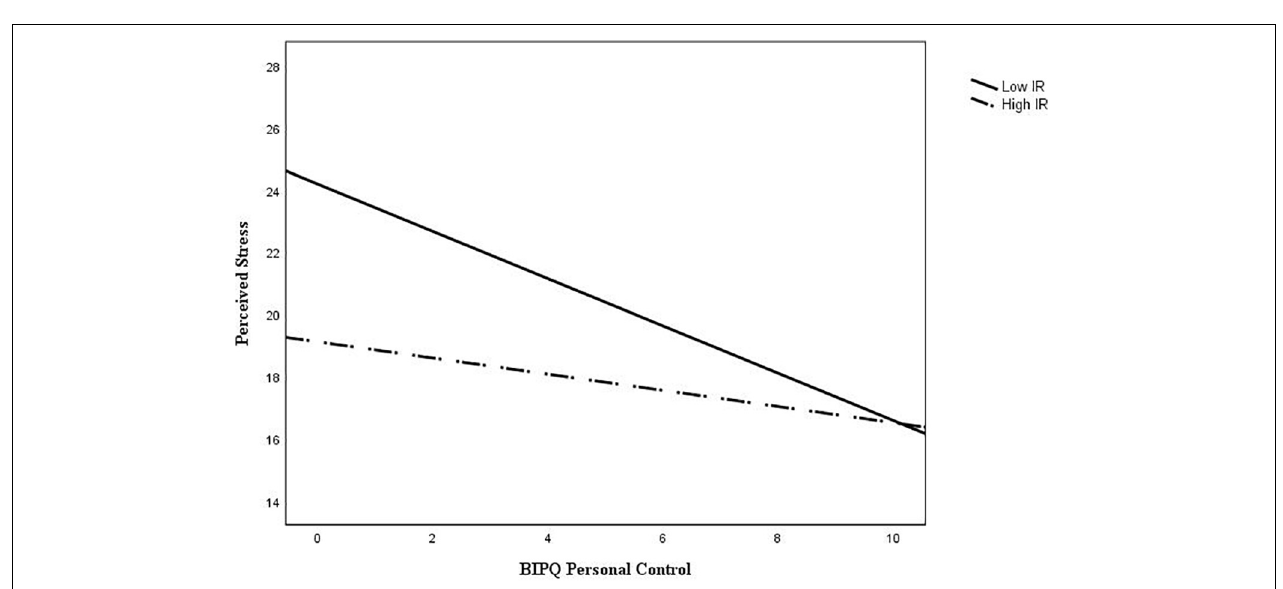
FIGURE 3 | Interaction plot of BIPQ personal control and perceived stress with internal religious (IR) expression as a moderator.